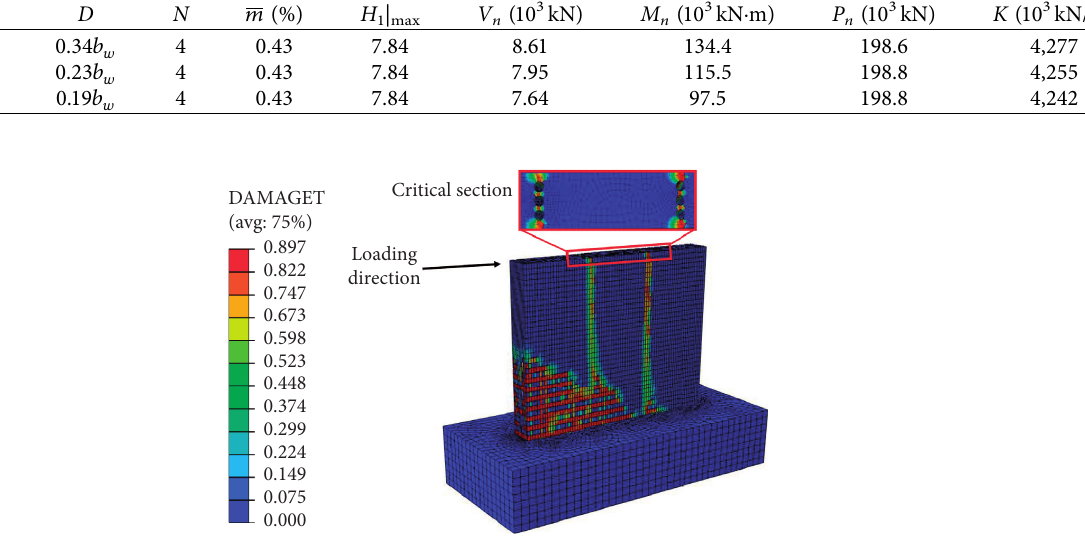
Figure 9: Concrete tension damage distribution of TLWD with three-layered embedment profile (DMAGET indicates tension damage of the concrete).